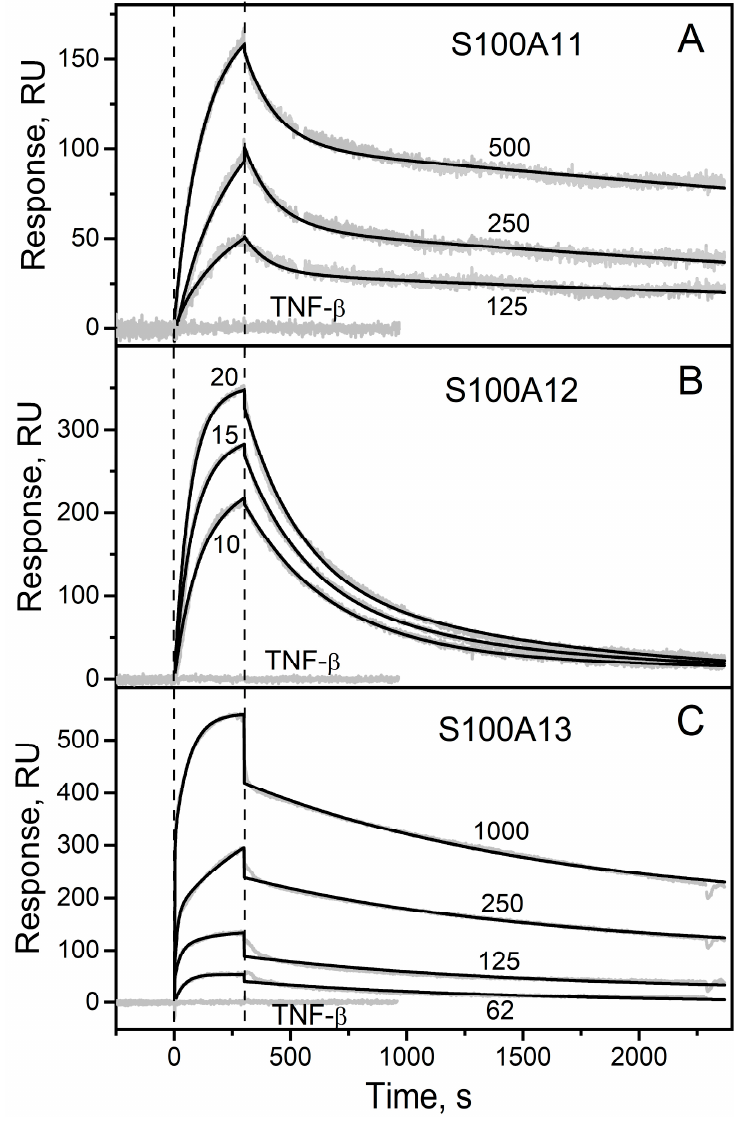
Figure 1. Kinetics of the interaction of sTNF with Ca 2+ -loaded proteins S100A11 (panel ( A )), S100A12 ( B ) or S100A13 ( C ) at 25 °C, monitored by SPR spectroscopy (10 mM HEPES, 150 mM NaCl, 1 mM CaCl 2 , 0.05% TWEEN 20, pH 7.4). sTNF is immobilized on the sensor chip surface by amine cou- pling. The S100 protein concentrations in nM are indicated for the sensograms. The sensograms for TNF- β used as a ligand and S100 protein concentration of 2 µM are shown. The grey curves are experimental, while the black curves are calculated according to the heterogeneous ligand model (see Section 3.2) (see Table 1). The vertical dotted lines mark the association phase, followed by the dissociation phase. Table 1. Parameters of the heterogeneous ligand model (see Section 3.2), describing the SPR data on the kinetics of interaction between sTNF and S100 proteins at 25 ◦ C, shown in Figure 1.